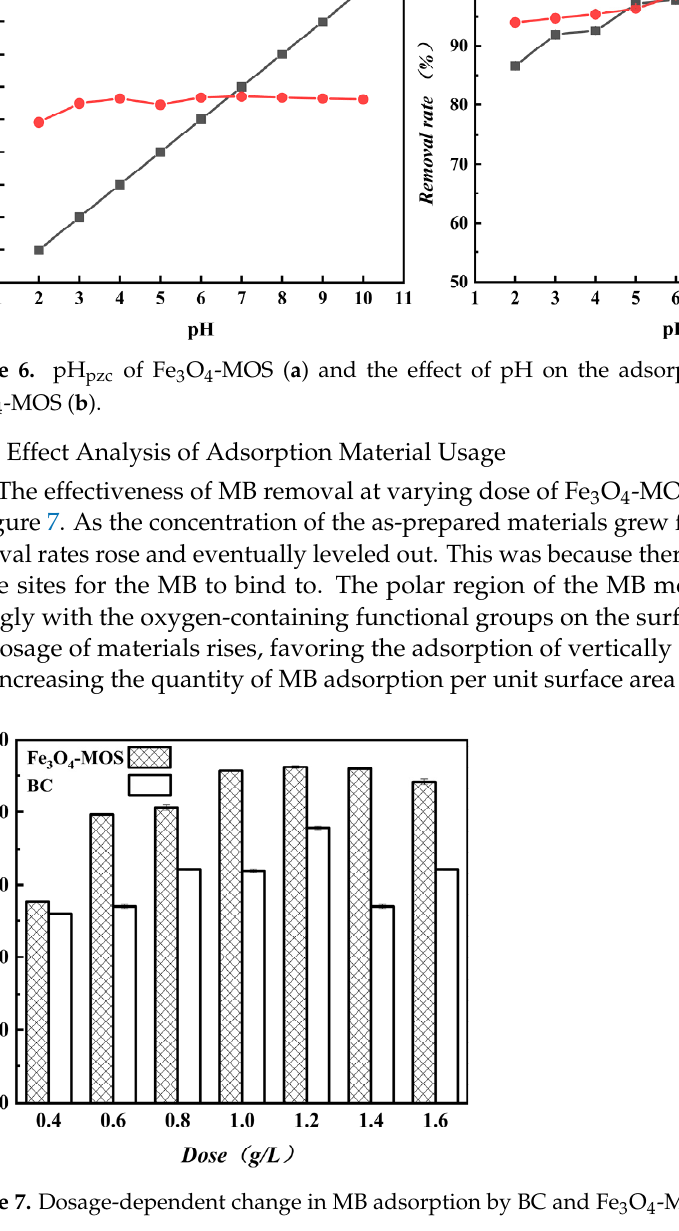
8 of 21 Figure 5. N 2 adsorption isotherm ( a ) and pore size distribution ( b ) of Fe 3 O 4 − MOS. 3.2. Adsorption Property Analysis 3.2.1. Effect Analysis of Adsorption System pH In the adsorption experiment of MB, which used as-prepared materials as adsorbent, it could be found from the Figure 6b that whether the Fe 3 O 4 -MOS or BC, the removal rate of MB increased with increases in the pH of solution from 2 to 6 (Fe 3 O 4 -MOS was 94% to 99%, BC was 87% to 98%). It was possible that protonation of the acidic functional groups, electrostatic repulsion between adsorbents containing H + and cationic MB, and competi- tion for adsorption sites between H + and MB all contributed to the reduced adsorption capacity under acidic circumstances. With the increase of the pH, the functional groups of samples and the adsorption solution deprotonated, and negatively charged active sites were formed on the surface, which bound more MB anions through electrostatic interac- tion. The charged MB molecules exhibited the least electrostatic repulsion with the Fe 3 O 4 - MOS and the strongest π - π dispersion force when the pH of the MB solution was near to the pH pzc (6.7) of Fe 3 O 4 -MOS (Figure 6a). For BC, the removal rate of MB decreased from 98% to 90% as the pH of solution exceeded 6. As seen from Figure 4, there were more oxygen-containing functional groups on the BC than Fe 3 O 4 -MOS, it was easier to prompt n- π interactions between the oxygen electron pairs of hydroxyl group (n-electron donors)